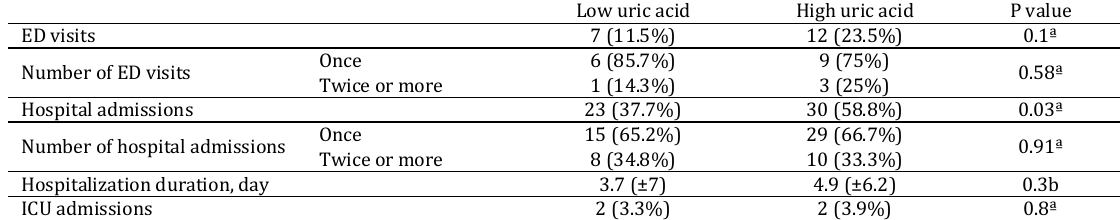
Table 2. Comparison of emergency department visit, hospital admission, hospitalization duration, and ICU admission between the low uric acid (<6.5 mg/dL, N= 61 patients) and high uric acid (≥6.5 mg/dL, N= 51 patients) groups